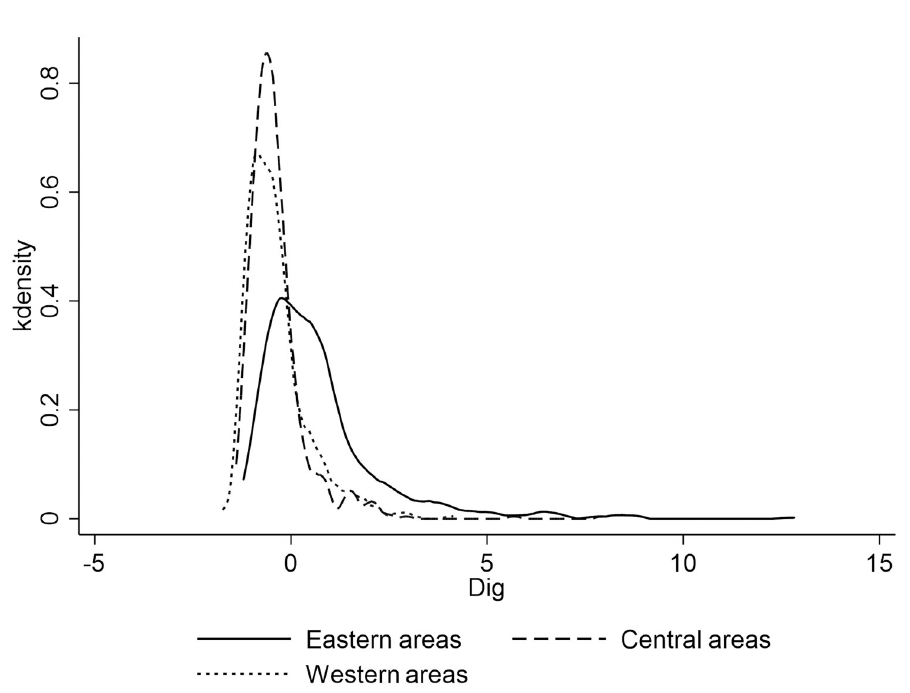
Fig 3. Kernel density estimation of the digital economy by areas.